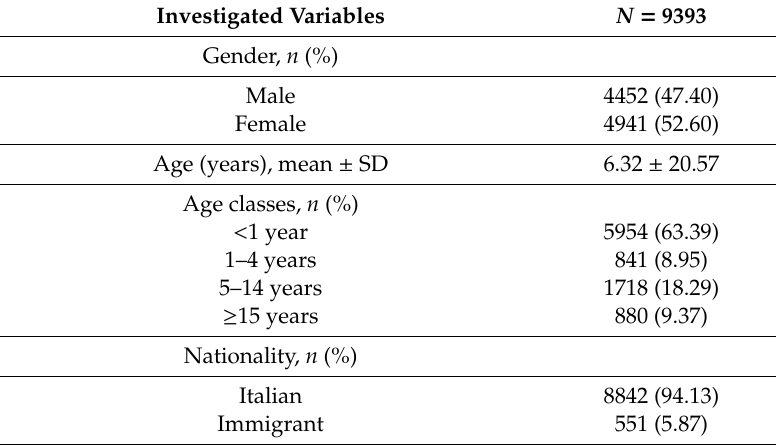
Table 1. Characteristics of the patients hospitalized for pertussis in 2002–2016, in